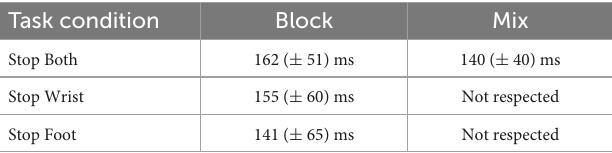
TABLE 2 Mean Stop Signal reaction time (SSRTs) and SDs across participants in task conditions where the assumption of independence was